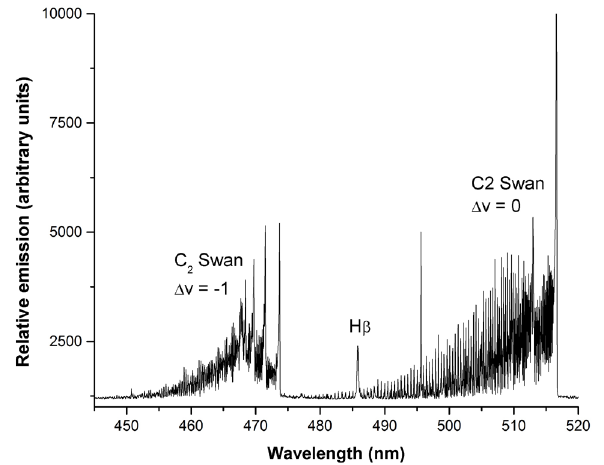
line in reductive conditions in β